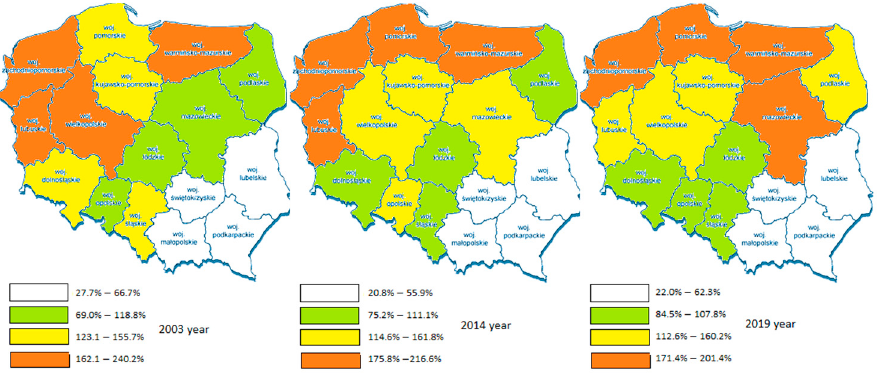
Figure 1. Distribution dynamics of the gross value added per person working in relation to the country (%). (Own study, based on the Local Data Bank).